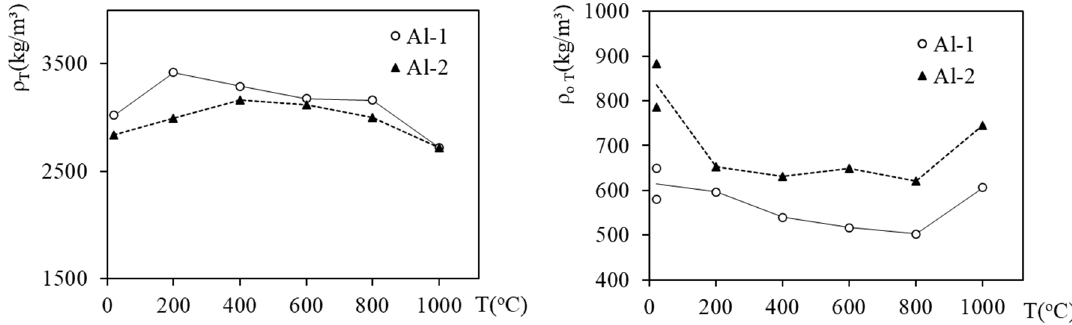
Figure 5. Density ρ and apparent density ρ o in kg/m 3 of heated geopolymer foams.